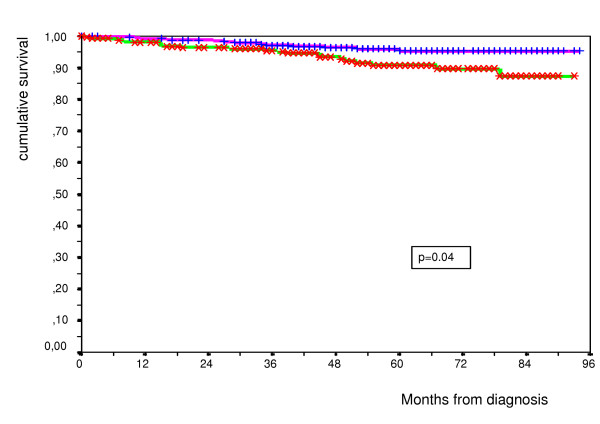
5-year survival in N- BC. 5-year OS values of N- breast cancers between MSP participants and non-participants were equal to 95% and 91% respectively (Log Rank = 5.74). [ = MSP participants;  = MSP non-participants]